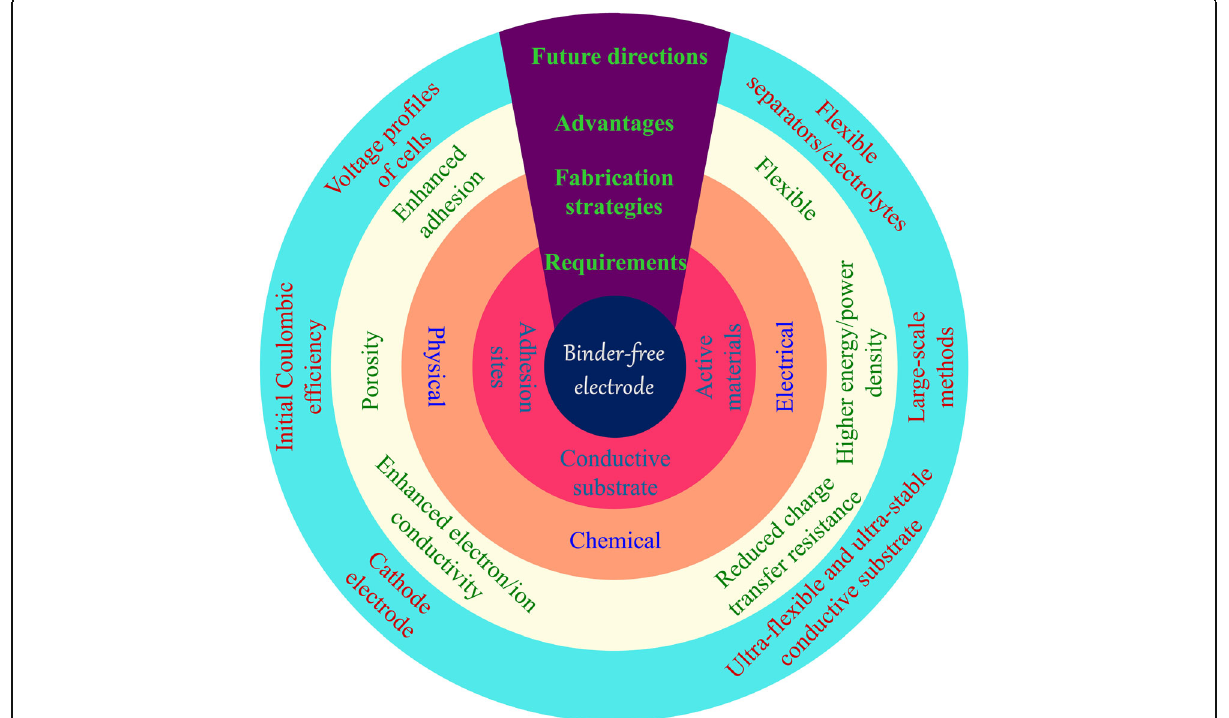
Fig. 1 The requirements, fabrication methods, advantages, and future development for binder-free